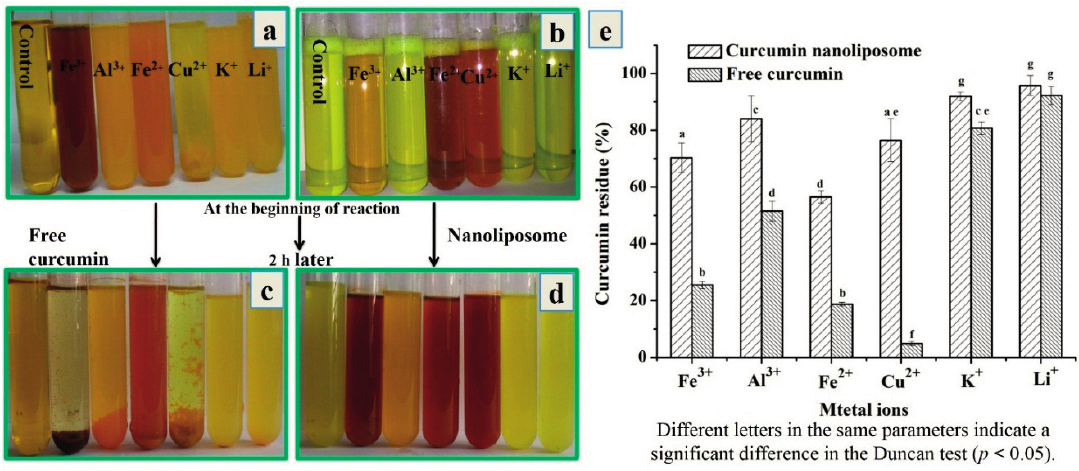
Figure 6. Photographs of mixtures of free curcumin-metal ion solutions ( a ); curcumin nanoliposomes-metal ion solutions ( b ) at the beginning of reaction; free curcumin-metal ion solutions ( c ); curcumin nanoliposomes-metal ion solutions ( d ) after 2 h of incubation; ( e ) residual curcumin amount in the mixture of free curcumin-metal ion solutions ( c ); curcumin nanoliposomes-metal ion solutions after 2 h of